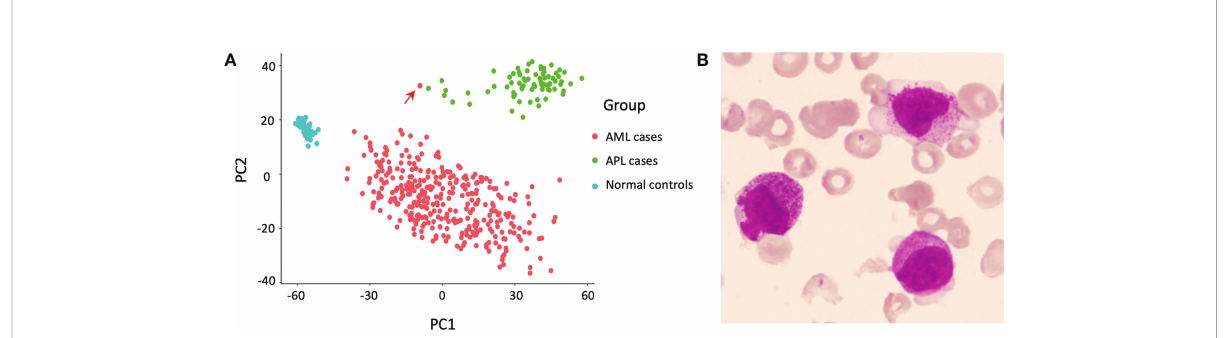
FIGURE 1 Discovery of the index case. (A) Principal component analysis revealed one relapsed acute myeloid leukemia (AML) case (indicated by the red arrow) separate from other AML cases, but adjacent to the cluster of acute promyelocytic leukemia (APL) cases. (B) Morphology of the bone marrow (BM) smear at relapse, Wright ’ s